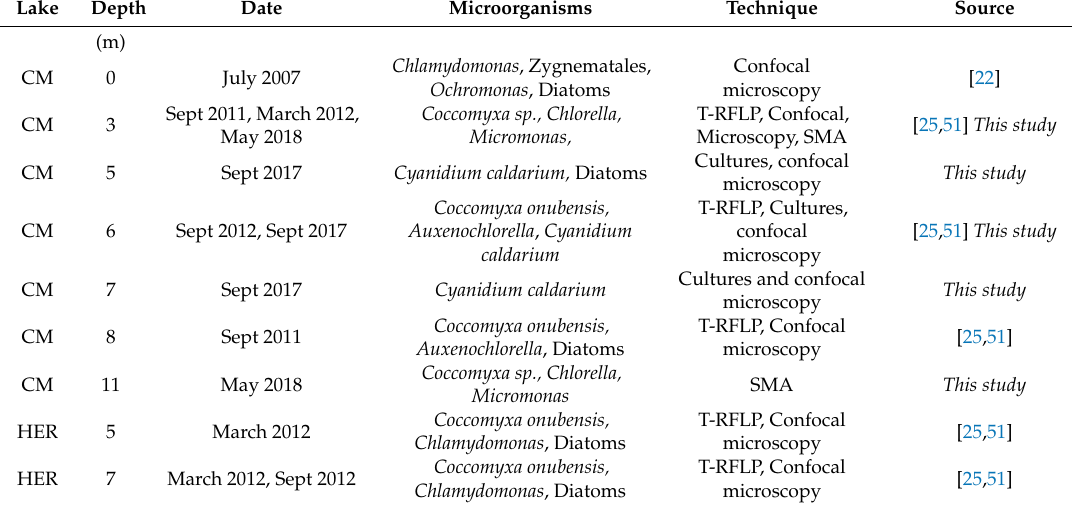
Table 3. Summary of phototrophic microorganisms identified at di ff erent depths and by di ff erent techniques in acidic pit lakes of the Iberian Pyrite Belt (IPB) (names in bold denote dominant